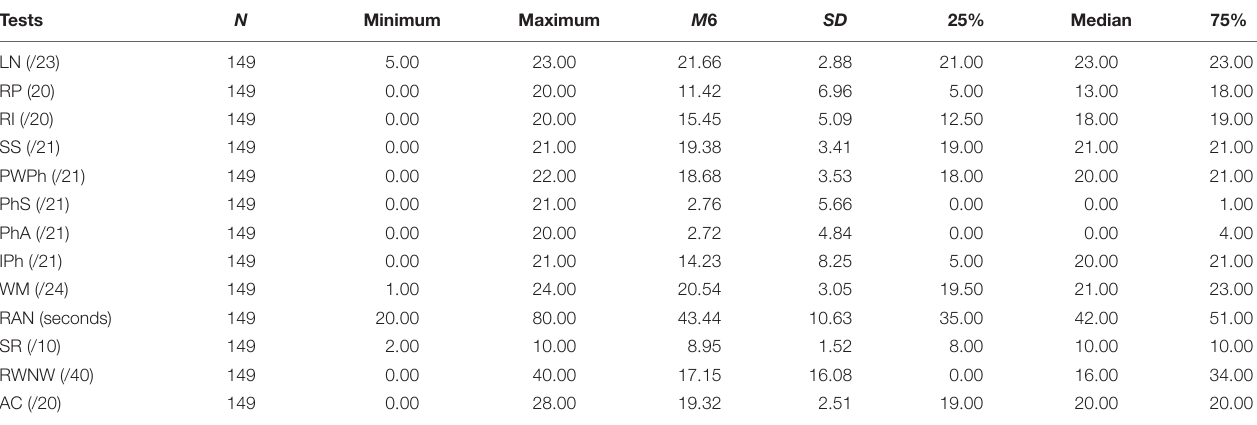
TABLE 2 | Distribution of mean ( M ), standard deviation ( SD ), minimum (min), and maximum values (max), and students’ test scores at the 25th and 75th percentiles using the proposed protocol.